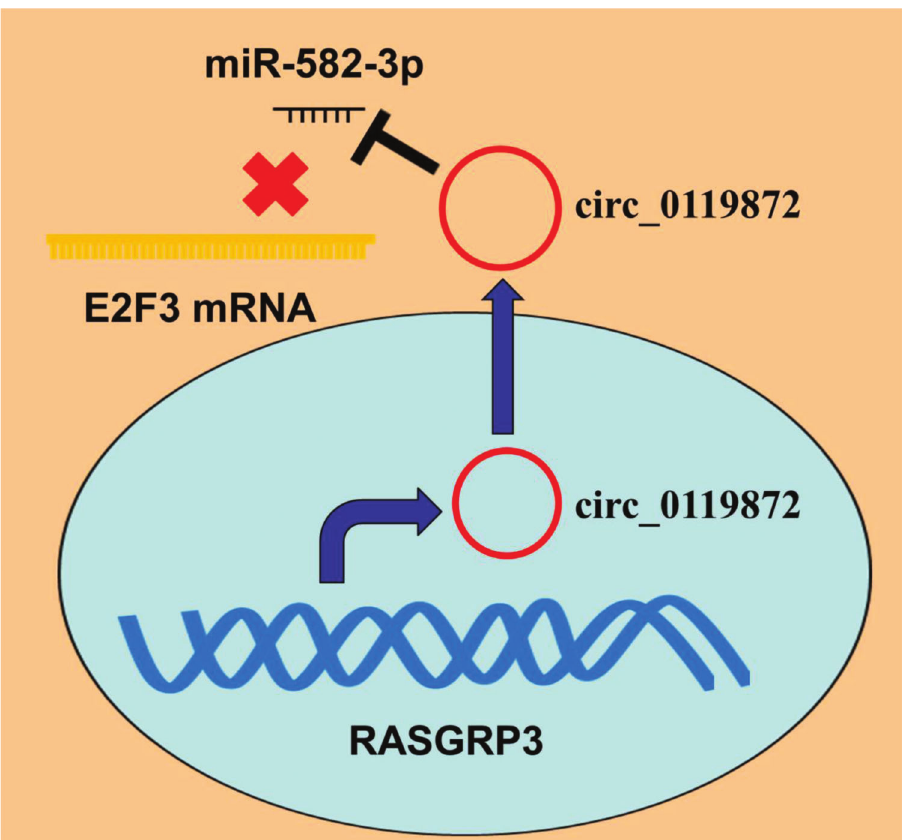
Figure 5 - Graphic Abstract: circ_0119872 enhances MM progression by adsorbing miR-582-3p and upregulating the expression of